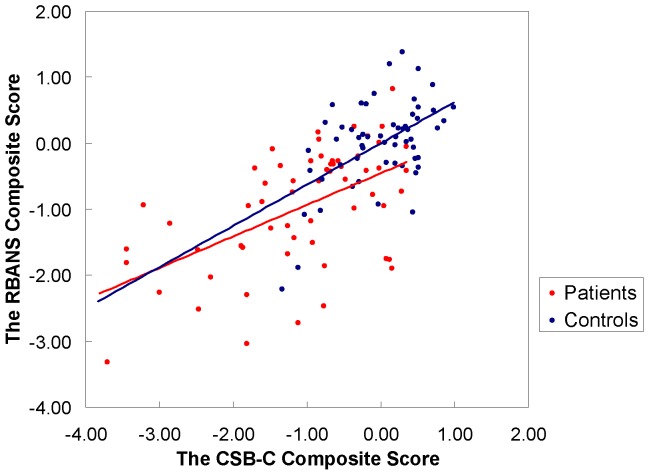
Inter-correlations between the CSB-C composite score and the RBANS composite score.Controls: r  = 0.53, p<0.01, Patients: r  =  0.544; p<0.001, Total subjects: r  =  0.67, p<0.001